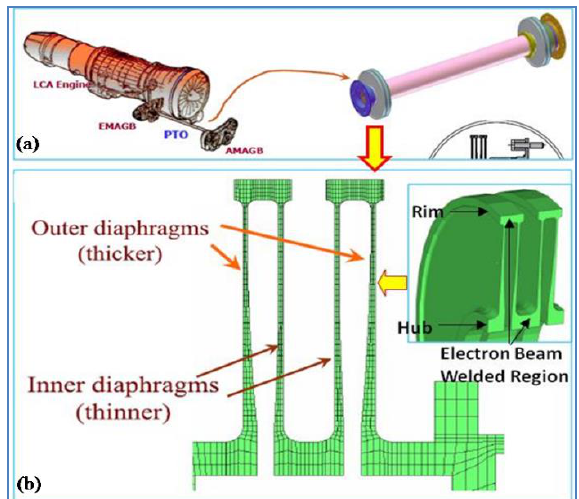
Fig. 4: (a) Schematic view of PTO shaft, EMAGB and AMAGB assemblies of aircraft system, (b) detailed schematic drawing of the flexible diaphragm couplings.